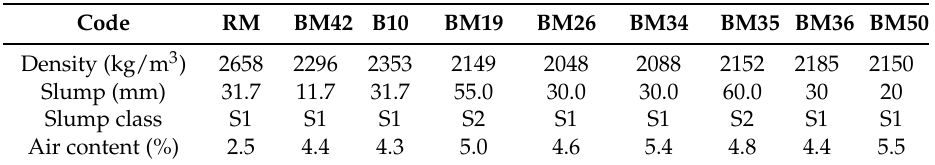
Table 3. Properties of fresh concrete